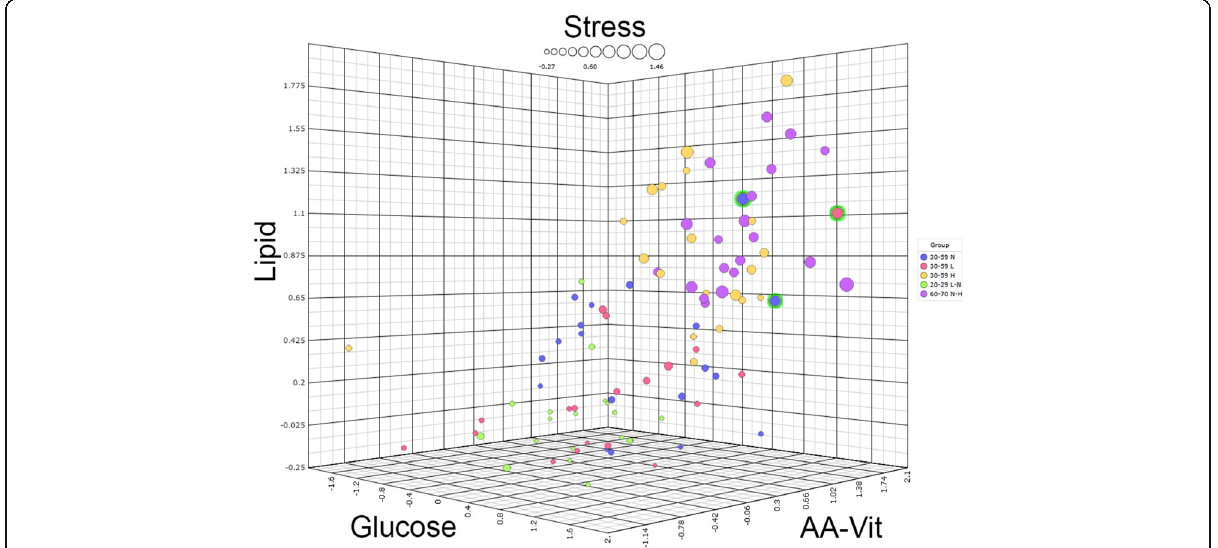
Fig. 3 The main health space, with both sexes included. Three spatial axes are labeled for the domain they represent. “ AA-Vit ” stands for amino acids and vitamins. The dot size represents the “ metabolic stress ” axis of the health space. Groups labeled using their respective age intervals as well as their body fat percentage intervals, L for low, N for normal, and H for high. The three outlier subjects are encircled in green (subjects 12, 52, and